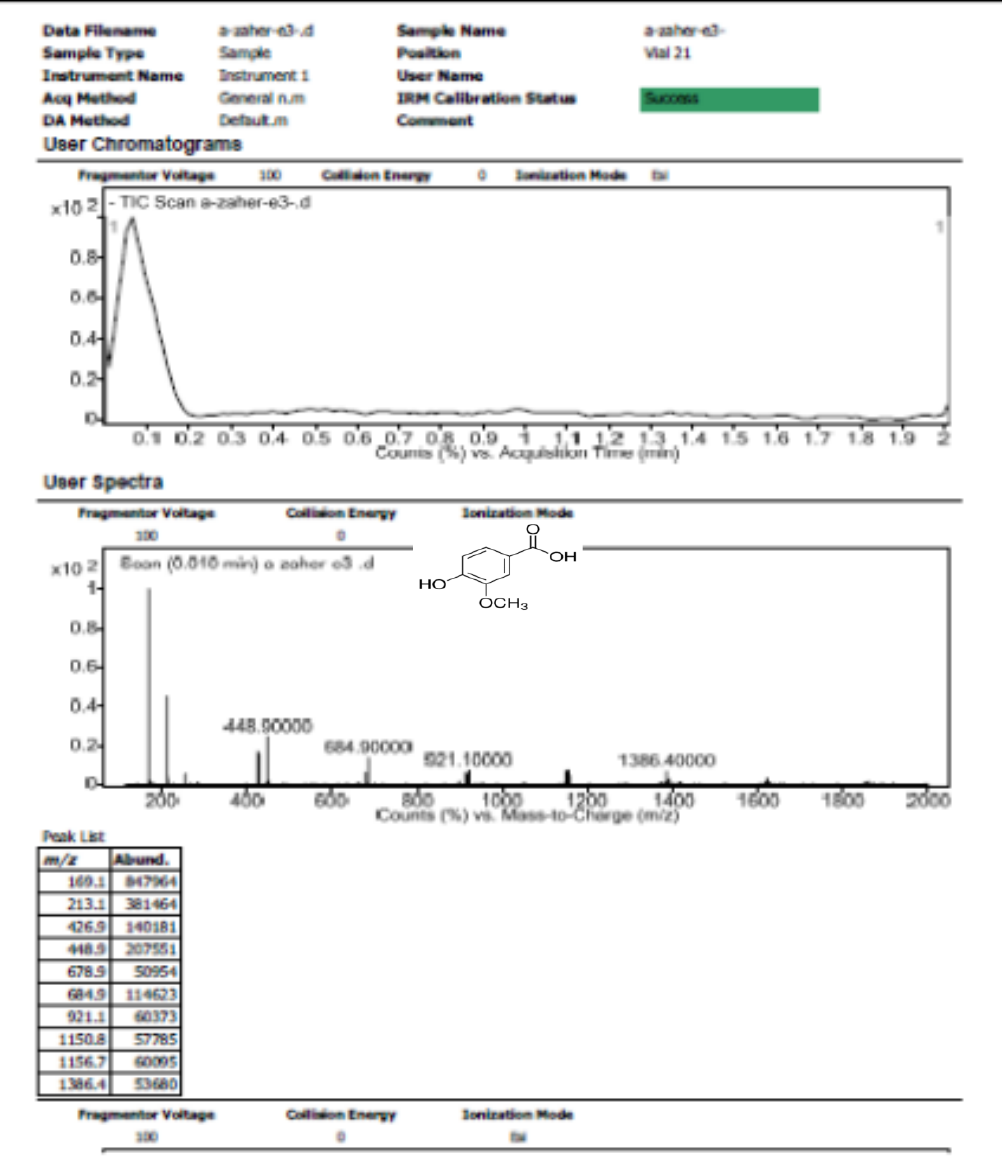
Figure 7. LC/MS chromatogram of isolated compound E1 All these data coincide with that reported for vanillic acid therefore compound E1 could be vanillic acid with mwt